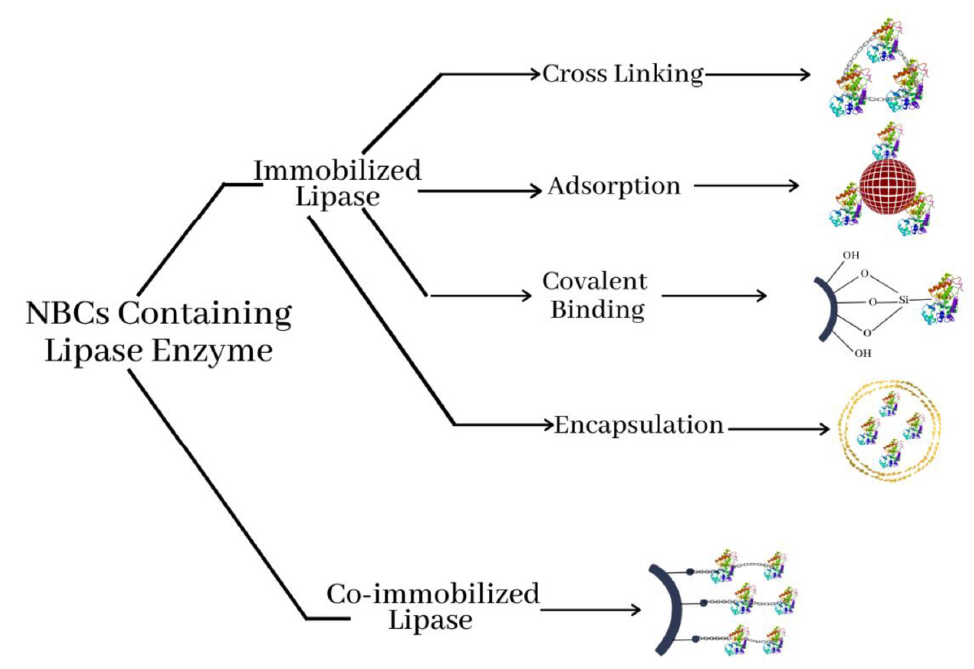
Figure 3. Enzyme immobilization methods used for the production of NBCs.